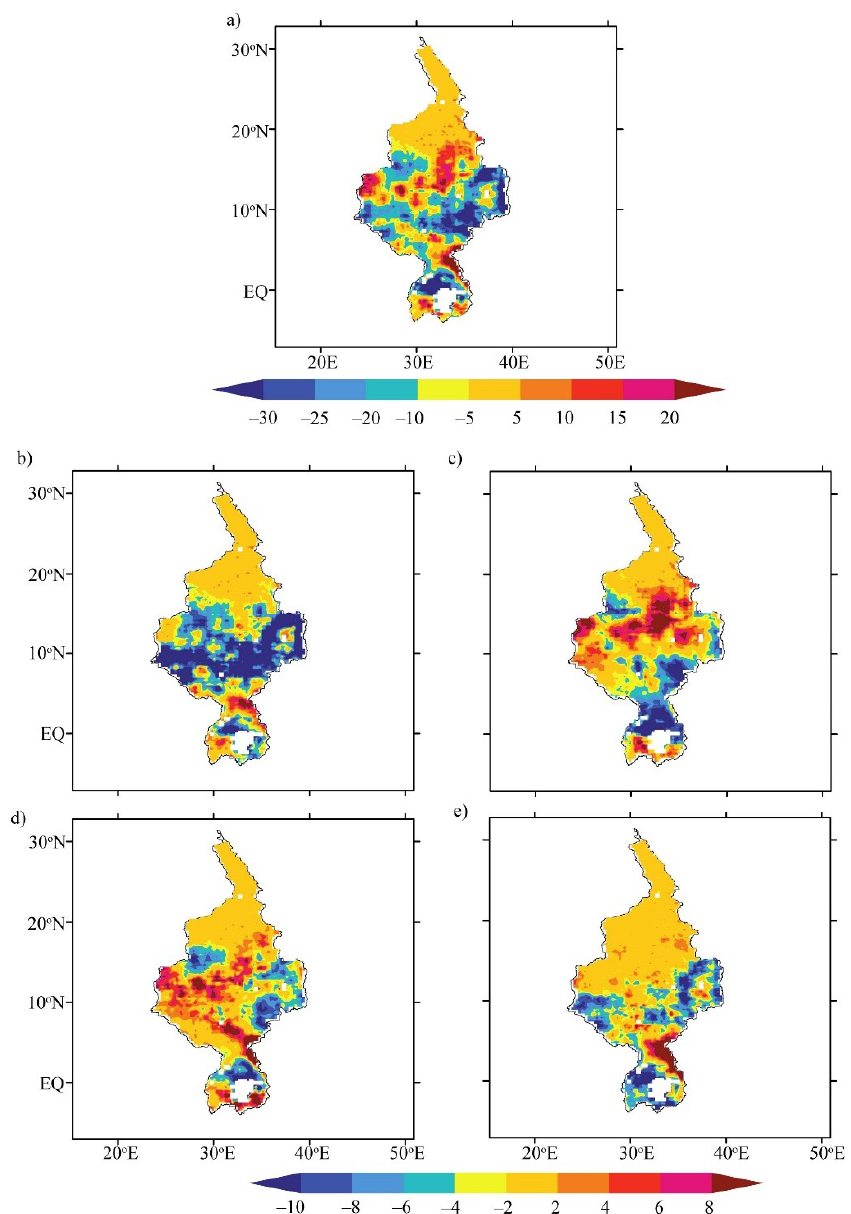
Figure 6. Spatial distributions of linear trends of total ET in the Nile Basin for the period 1980–2014: ( a ) whole year, ( b ) spring, ( c ) summer, ( d ) autumn, and ( e ) winter. The unit is mm / 10 years. Positive (negative) values indicate increasing (decreasing) trends in ET.